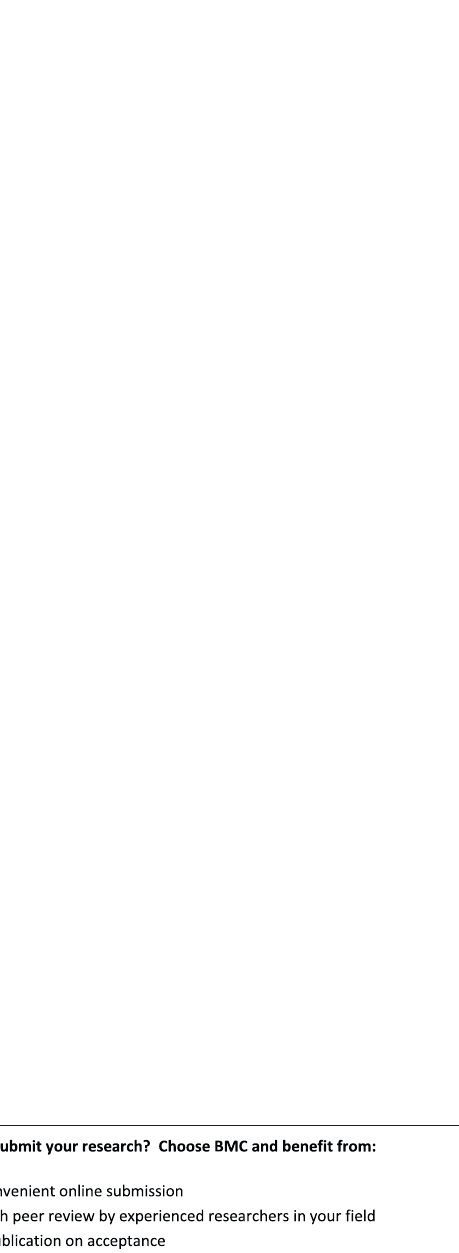
Springer Nature remains neutral with regard to jurisdictional claims in published maps and institutional